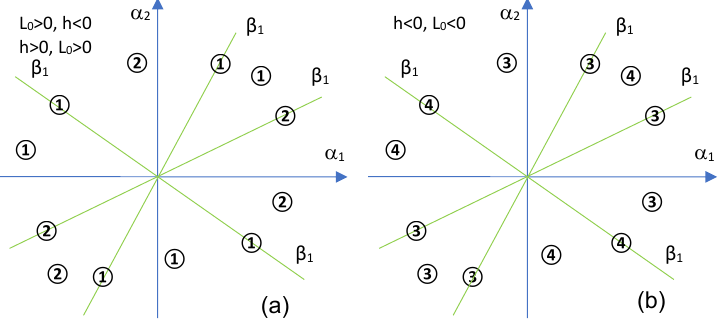
Figure 7. Bifurcation diagrams in the Case II and III when p < 0, r < 0, and ∆ 2 > 0: ( a ) L 0 > 0, h < 0 or h > 0, L 0 > 0; ( b ) h < 0, L 0 <